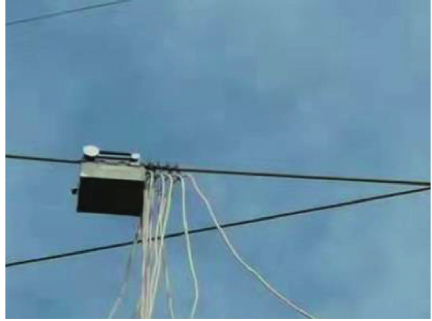
Figure 8: Practical application experiment of line changing